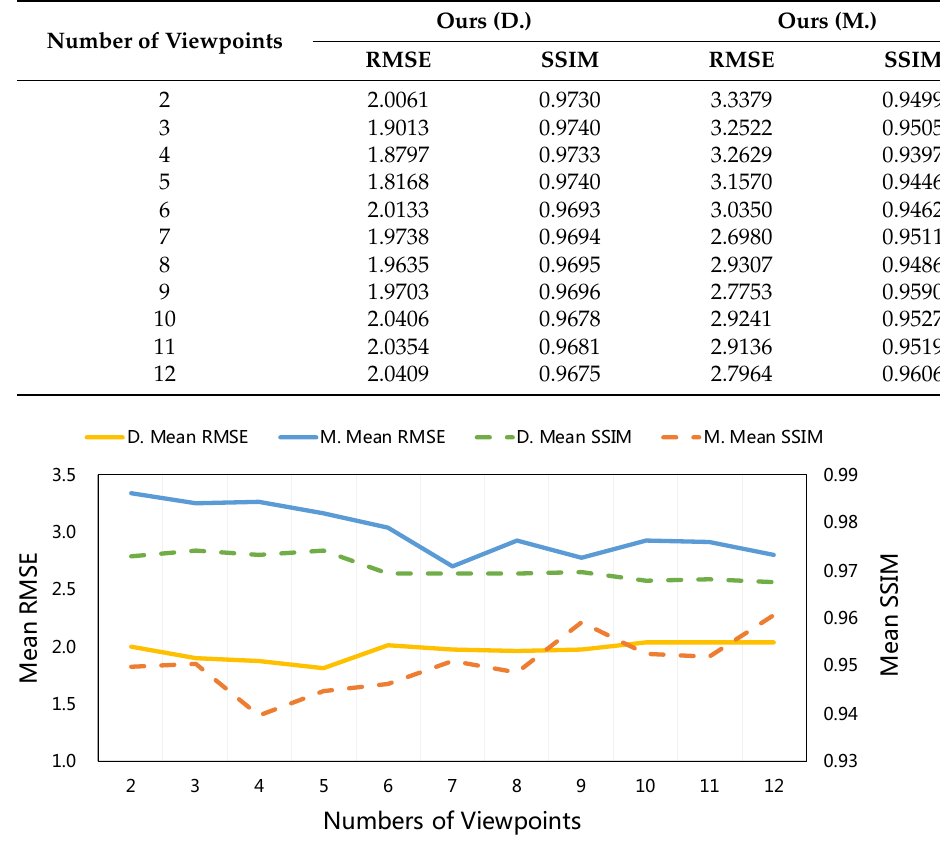
Figure 7. Comparison of experimental results on the number of